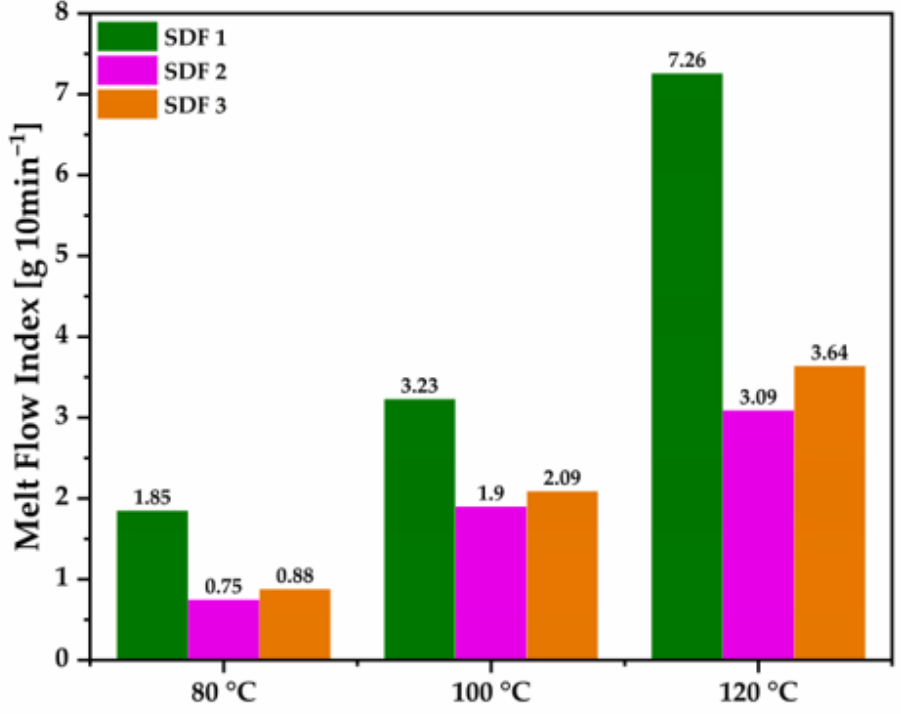
Figure 2. Melt flow index readings from extrudate granules of SDF 1, SDF 2, and SDF 3.